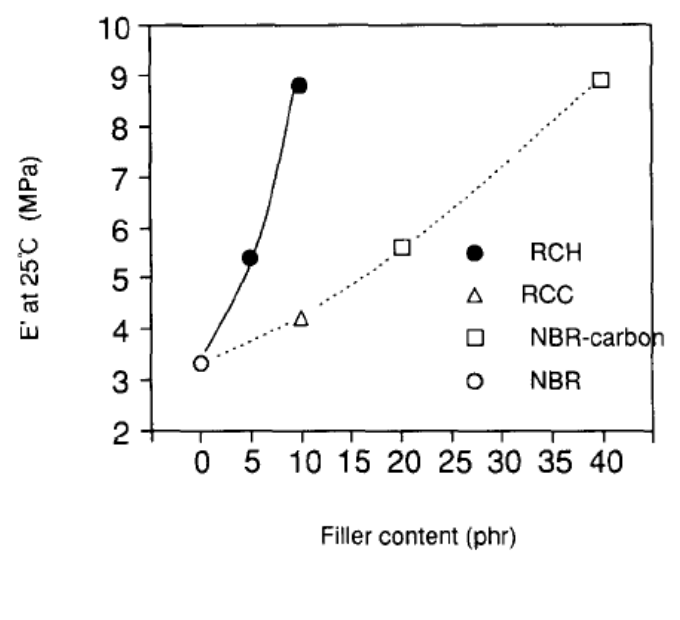
Figure 38. Elastic modulus of rubber clay hybrids as a function of filler volume fraction. Reproduced from reference [70] with permission from